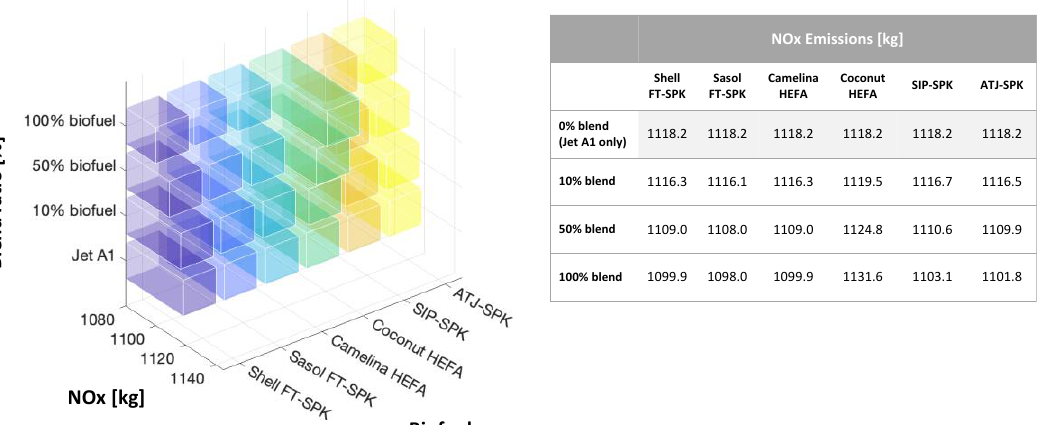
Figure 15. NOx overall emissions along the reference Concorde mission, with the impact of different biofuels and blending ratios.